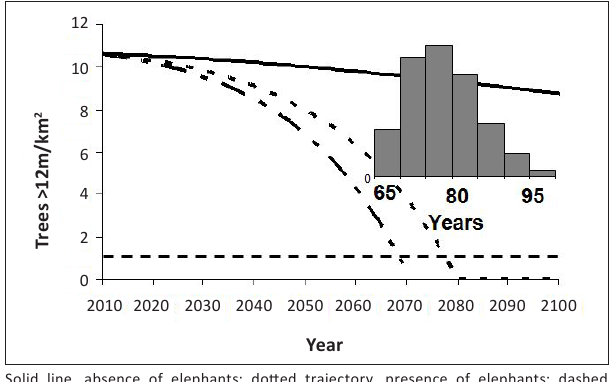
Solid line, absence of elephants; dotted trajectory, presence of elephants; dashed trajectory, lower 95th percentile. The indicator variable is trees taller than 12 m. The threshold (including safety margin) is set at one tree per km 2 . In the absence of elephants (solid line), the number of large trees continues to decline, slowly, over the next century. In the presence of elephants, the number falls below the threshold at a median year of 2078 (dotted trajectory), with the lower 95th percentile at 2069 (dashed trajectory). The inserted histogram is the distribution of dates at which the threshold is reached, for an ensemble of model runs, varying key parameters independently. FIGURE 2: An example of a model for a hypothetical elephant-tree system, based on data from the Kruger National Park.